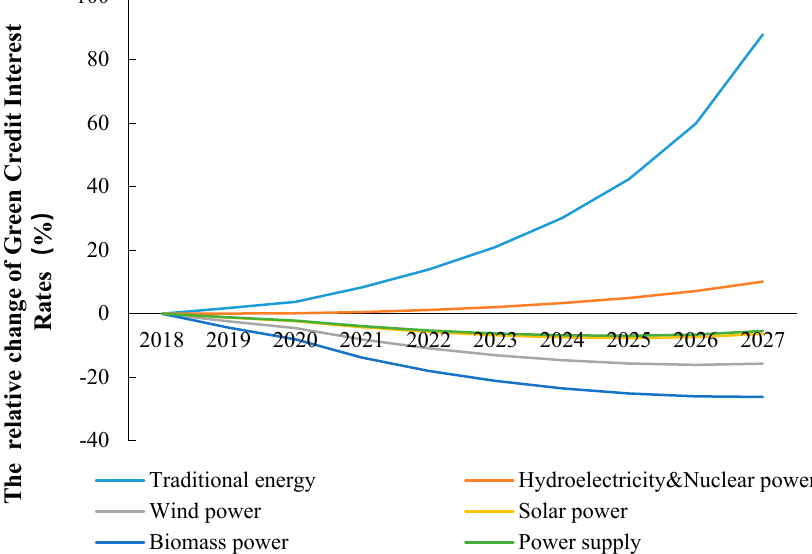
Figure 9. The relative change in green credit interest rates for energy sectors compared to benchmark, 2018–2027, China.